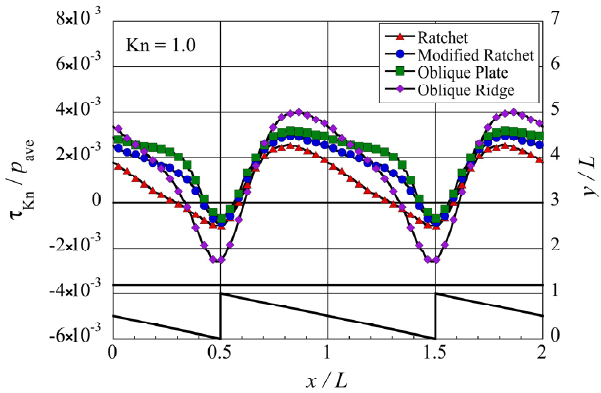
Figure 6. Distribution of the local tangential Knudsen stress, i.e., local propulsive force per unit area, for each case of the microstructure, at Kn = 1 . The silhouette of the ratchet structure is added for easy reference.